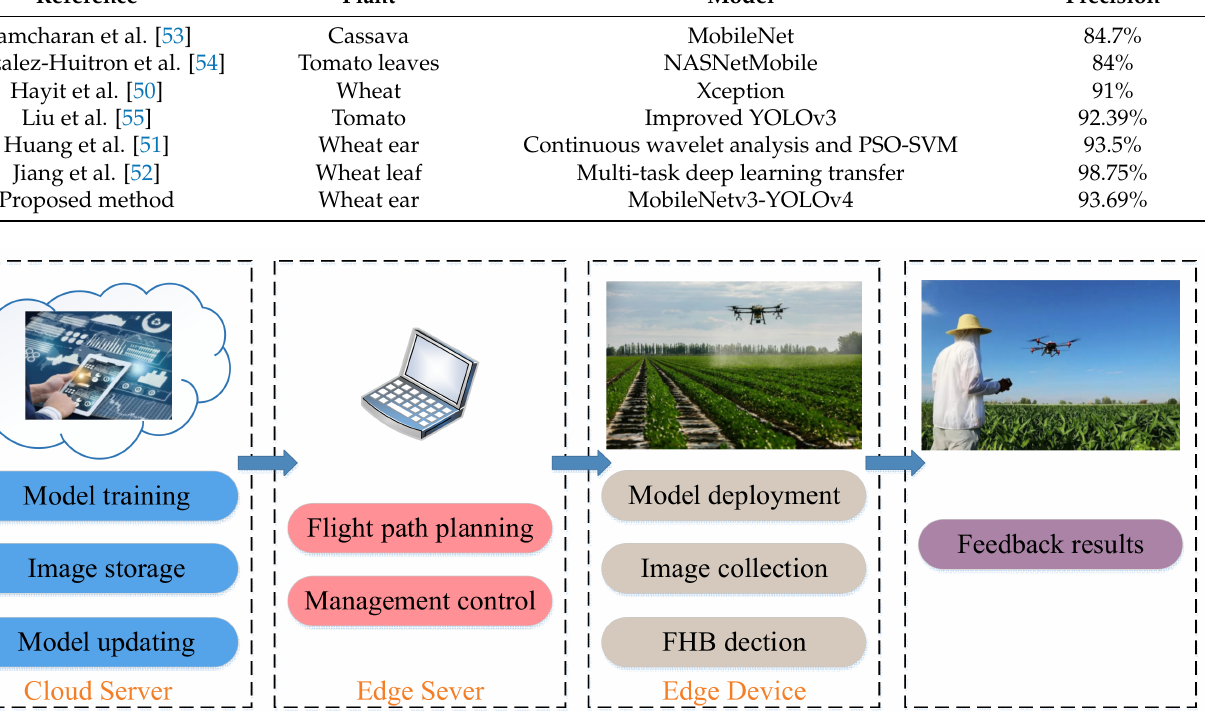
Figure 15. System